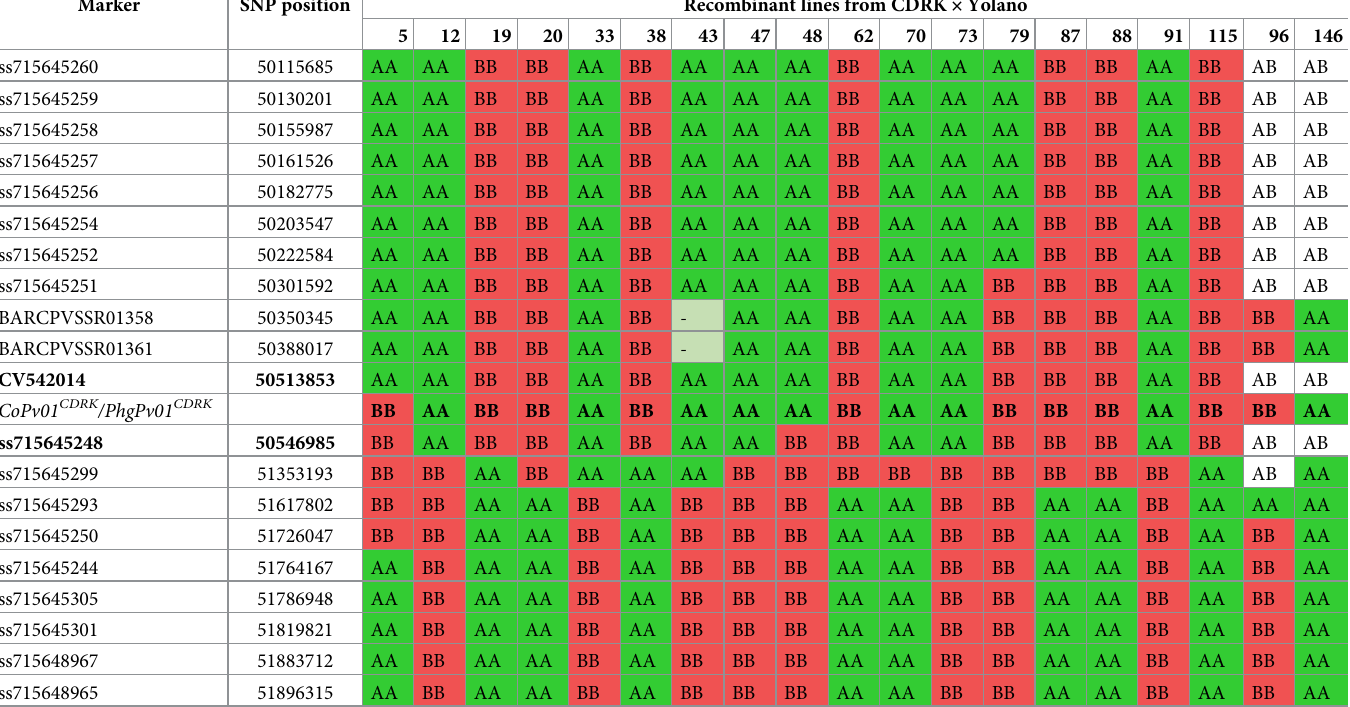
Table 3. Genotype and phenotype of 19 F 10 recombinant events in the region of Pv01 used for fine mapping of the anthracnose and angular leaf spot resistance loci in CDRK. The phenotype was obtained from the reaction of the 110 F 10 RILs to races 73, 2047, and 3481 of Colletotrichum lindemuthianum and race 63–39 of P . griseola . Genotyping was achieved using the flanking markers 12 SNP, two SSR and one STS markers that enabled the positioning of the CoPv01 CDRK /PhgPv01 CDRK l oci in a 33 kb genomic region flanked by markers CV542014 and ss715645248.